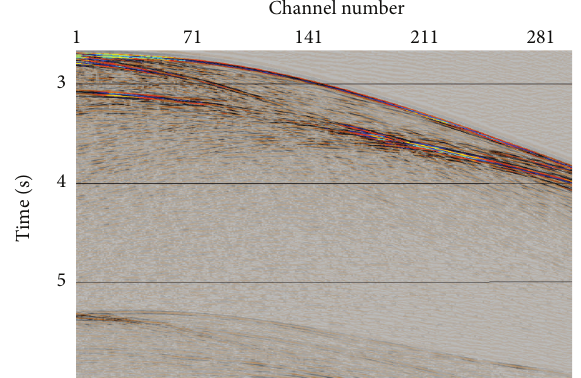
Figure 6: Total pressure wavefield at 15m depth for the outermost